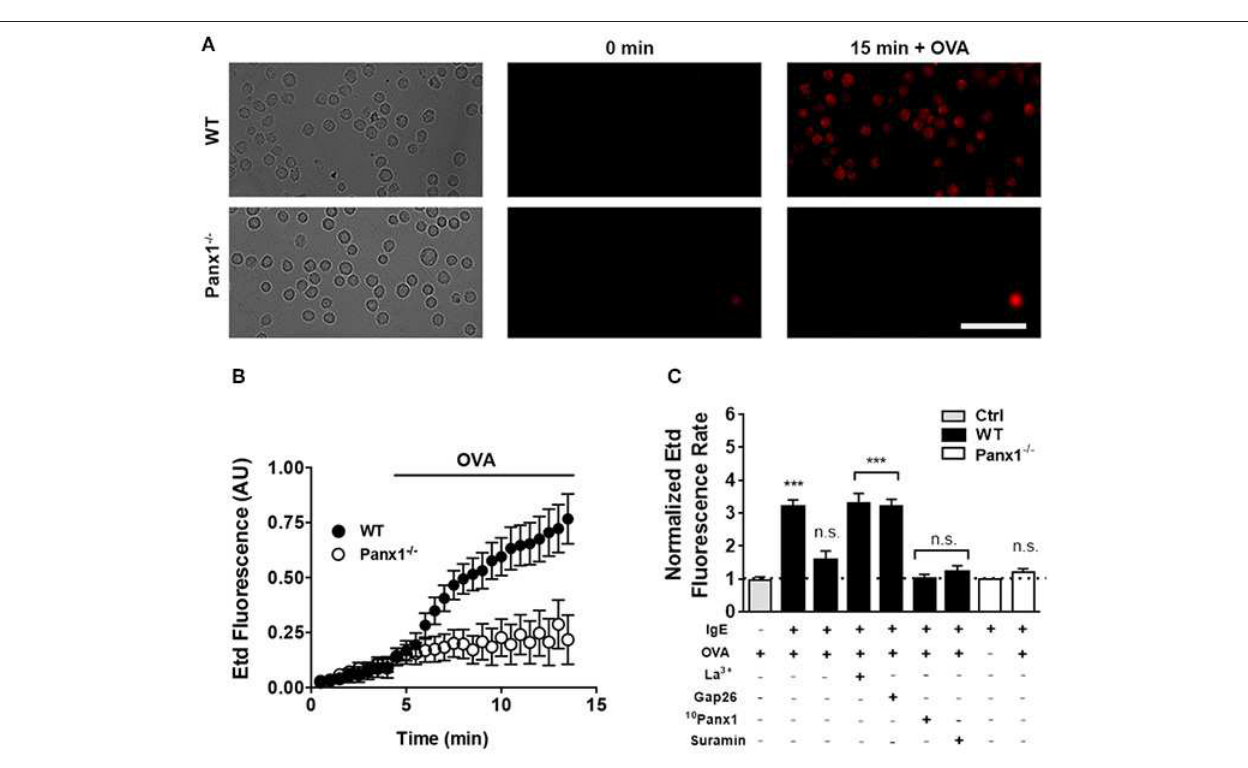
Frontiers in Immunology |